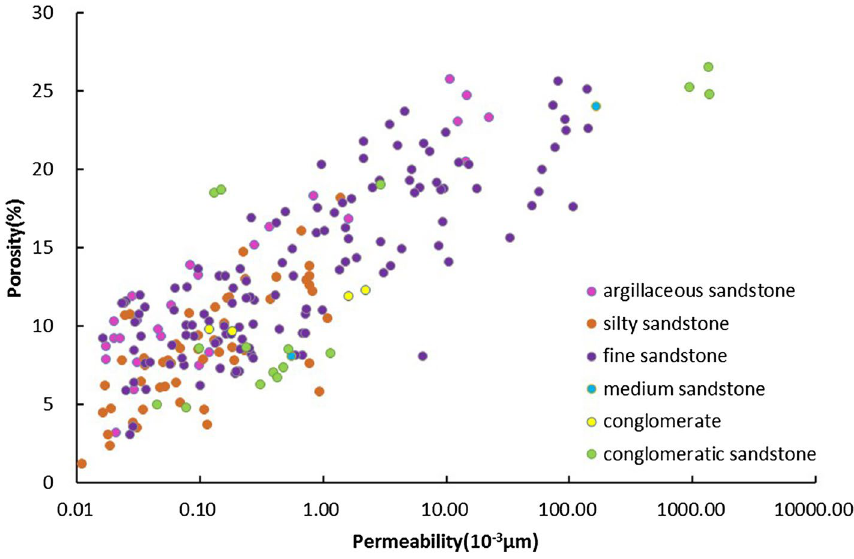
Fig. 5 Oil saturation values of argillaceous sandstone, silty sandstone, fine sandstone, medium sandstone, pebbly sandstone, conglomeratic sandstone and conglomerate reservoirs from the Oligocene Xiaganchaigou Formation (E 3 ) in the Lengdong area, Qaidam